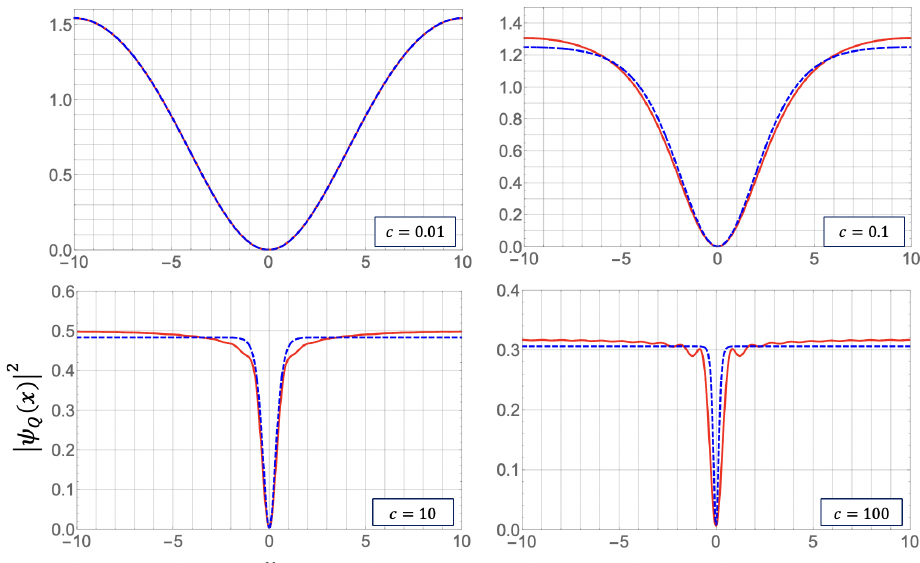
Figure 4. Square amplitudes of the matrix elements | ψ Q ( x ) | 2 for N = L = 20, and c = 0.01, 0.1, 10, and 100 (red solid curves) and the corresponding elliptic solutions (blue dashed curves). The corresponding quantum state is given by Equation (31), which has J = 1. In the panel of c = 0.01, the red solid curve agrees with the blue dashed curve.